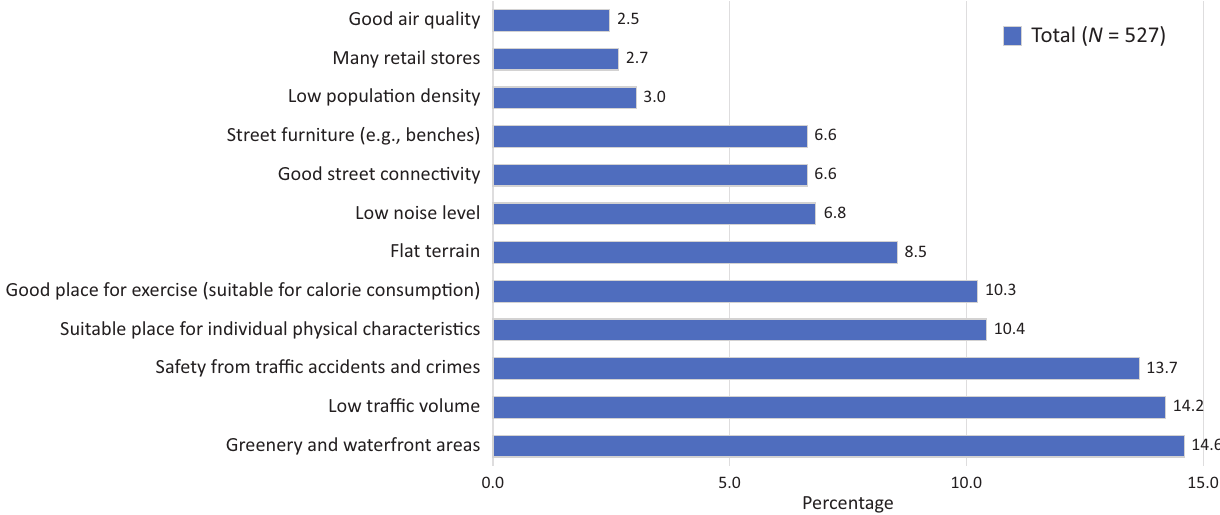
Figure 2. Preferred environmental factors in pedestrian navigation mobile application for the total sample.